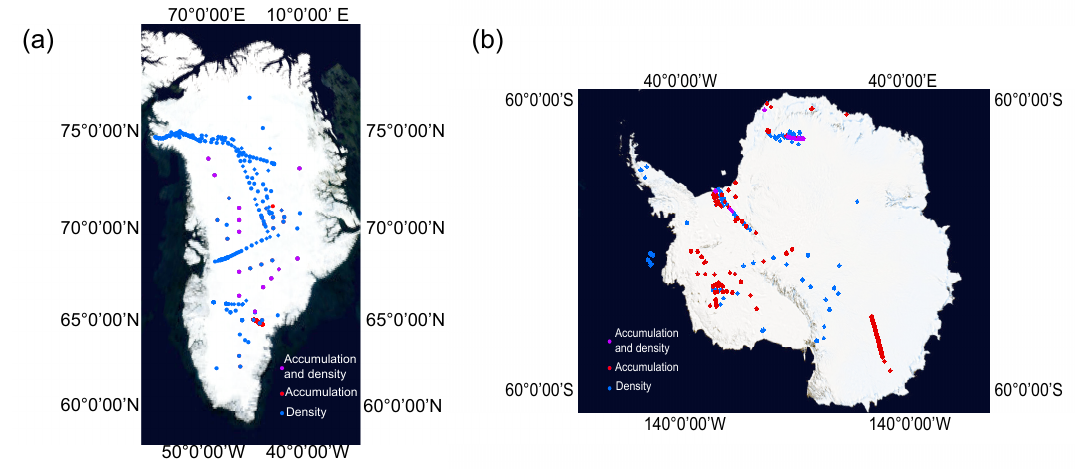
Figure 1. (a) Measurement locations for accumulation (red), snow density (blue), or both (purple) for the SUMup dataset on the GrIS. Snow depth on sea ice data for the Arctic are not shown. (b) Same as above but for the AIS. Locations on sea ice, those in the Bellingshausen Sea, include both snow density and snow depth on sea ice